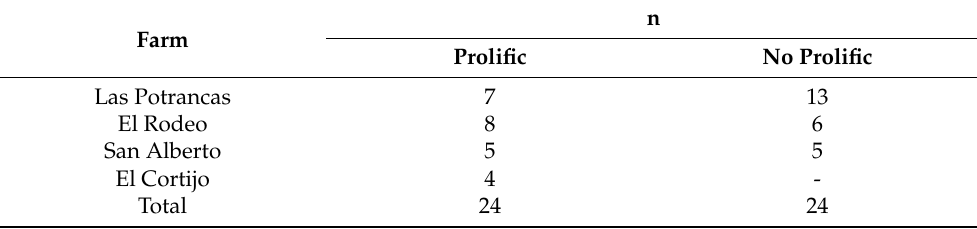
Table 1. Integration of the samples of prolific and non-prolific sheep from four Pelibuey sheep herds. n Farm Prolific No Prolific Las Potrancas 7 13 El Rodeo 8 6 San Alberto 5 5 El Cortijo 4 - Total 24